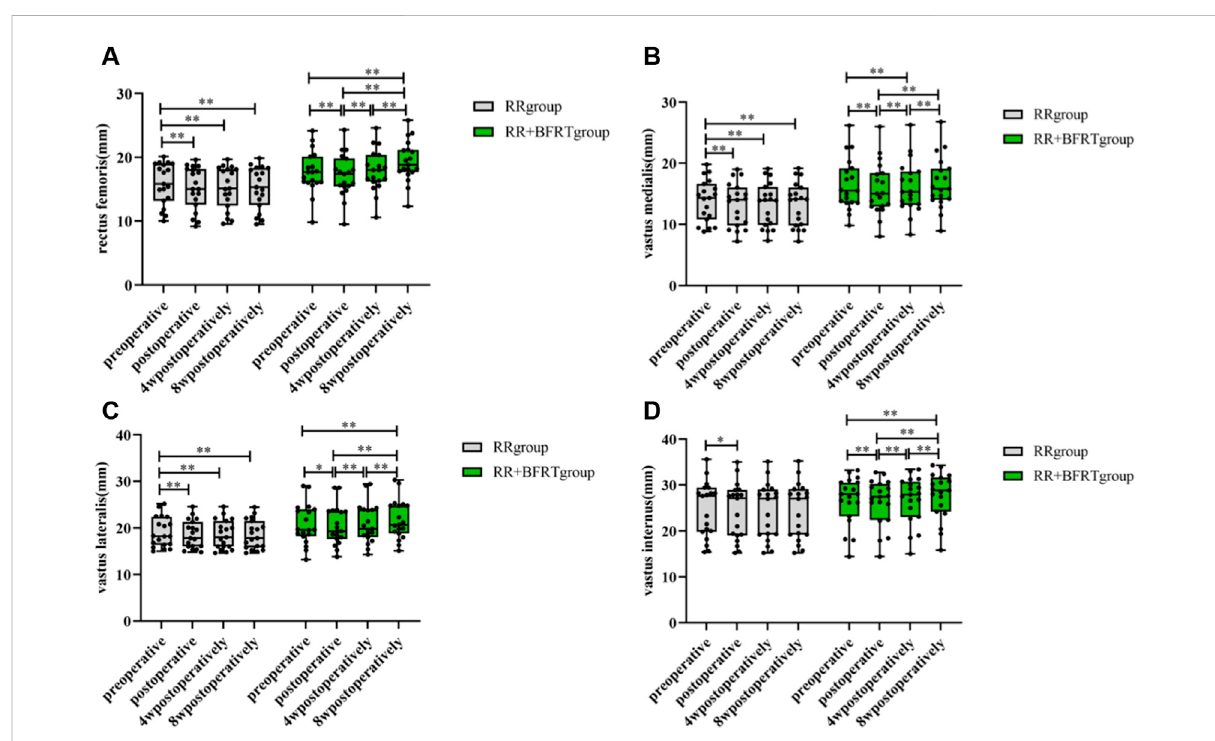
FIGURE 6 Intra-group comparison of quadriceps thickness in RR and RR + BFRT groups. “ * ” indicates a signi fi cant change ( p < 0.05). “ ** ” indicates a signi fi cant change ( p < 0.01). Values are presented as mean ± SD. RR Group: routine rehabilitation group; RR + BFRT Group: routine rehabilitation + blood fl ow restriction training group. [ (A) : Changes in rectus femoris thickness in the RR group and the RR + BFRT group; (B) Changes in vastus medialis thicknessintheRRgroupand theRR+BFRTgroup; (C) Changesinvastuslateralisthickness intheRRgroup andtheRR+BFRTgroup; (D) Changes in vastus intermedius thickness in the RR group and the RR + BFRT